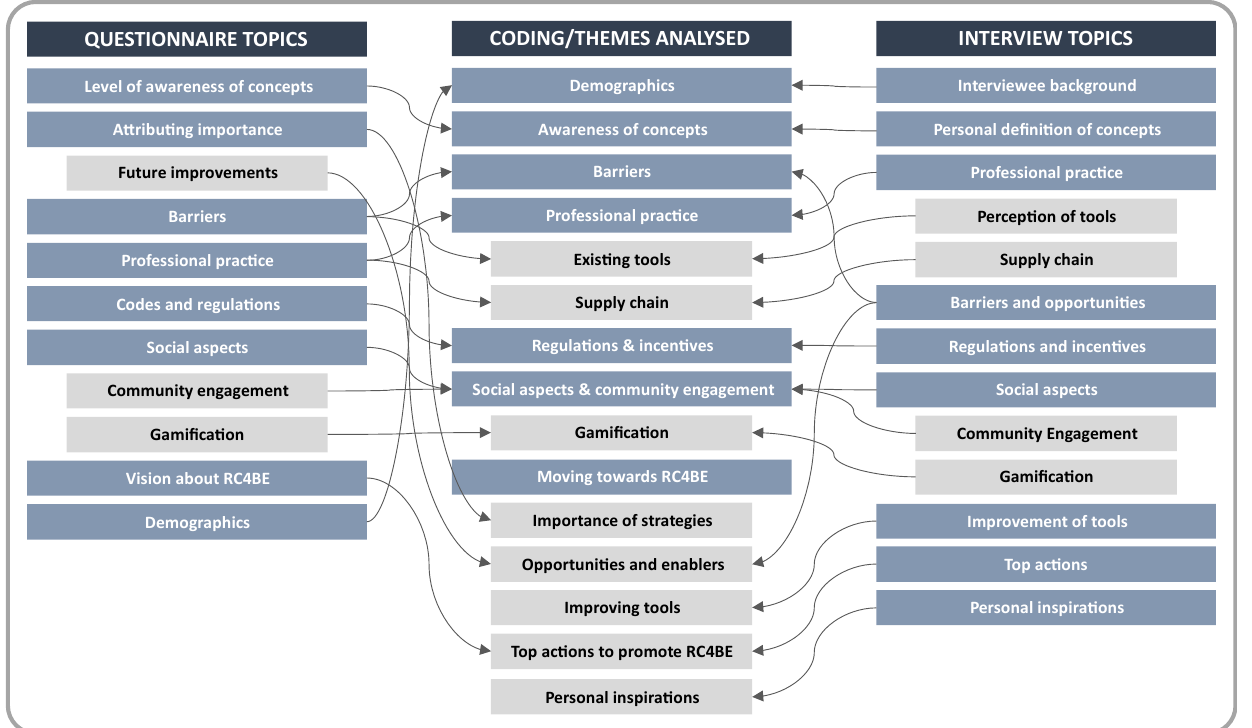
Figure 2. Merging between questionnaire/interview topics with coding/themes analysed. Blue and grey refer to topics and subtopics. grey refer to topics and